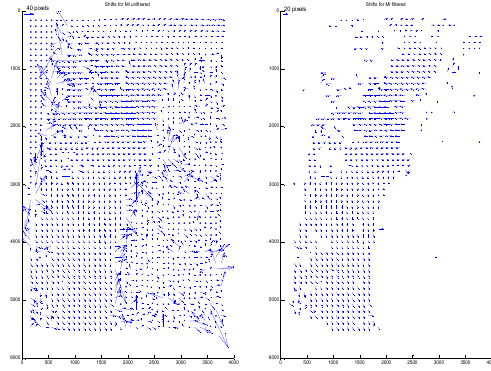
Figure 11. The shifts computed with MI before any filtering (left) and after the filtering was applied (right) with a threshold for the 40% of the best points.